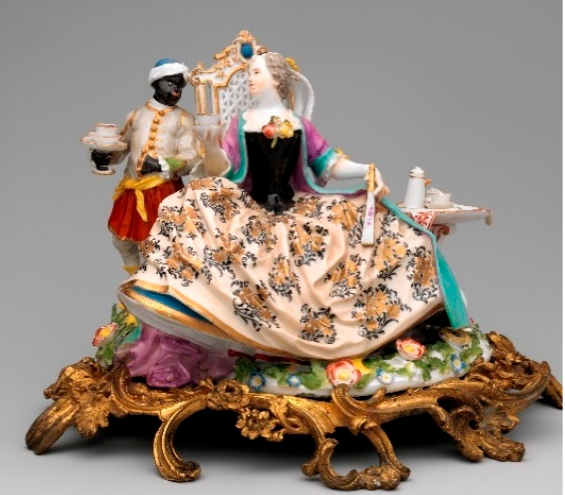
Figure 10. Johann Joachim Kändler Lady with attendant, Meissen Manufactory, ca. 1740, 64.101.59a, b. The Metropolitan Museum, New York. Public domain.